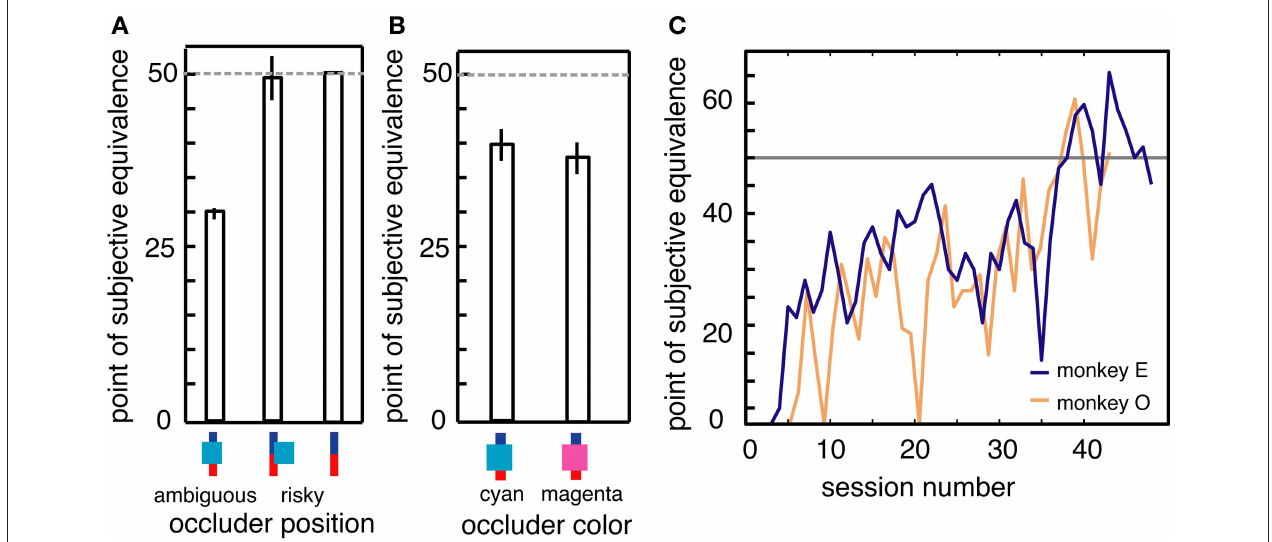
extensively tested monkeys, O (orange) and E (blue), plotted over the course of behavioral sessions. PSE indicates average level of aversion to ambiguous options for a session; values below 50% represent aversion, values at 50% (indicated by horizontal gray line) represent neutrality. Horizontal axis refers to recoding session number. Each session consisted of ∼ 1500–2500